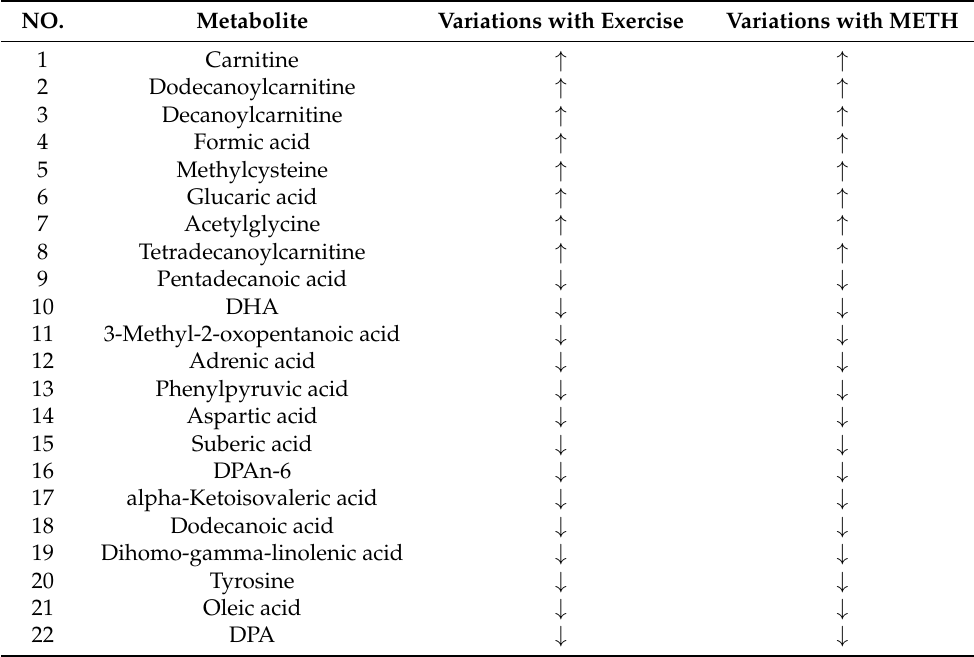
Table 4. Metabolites with same trends under exercise and